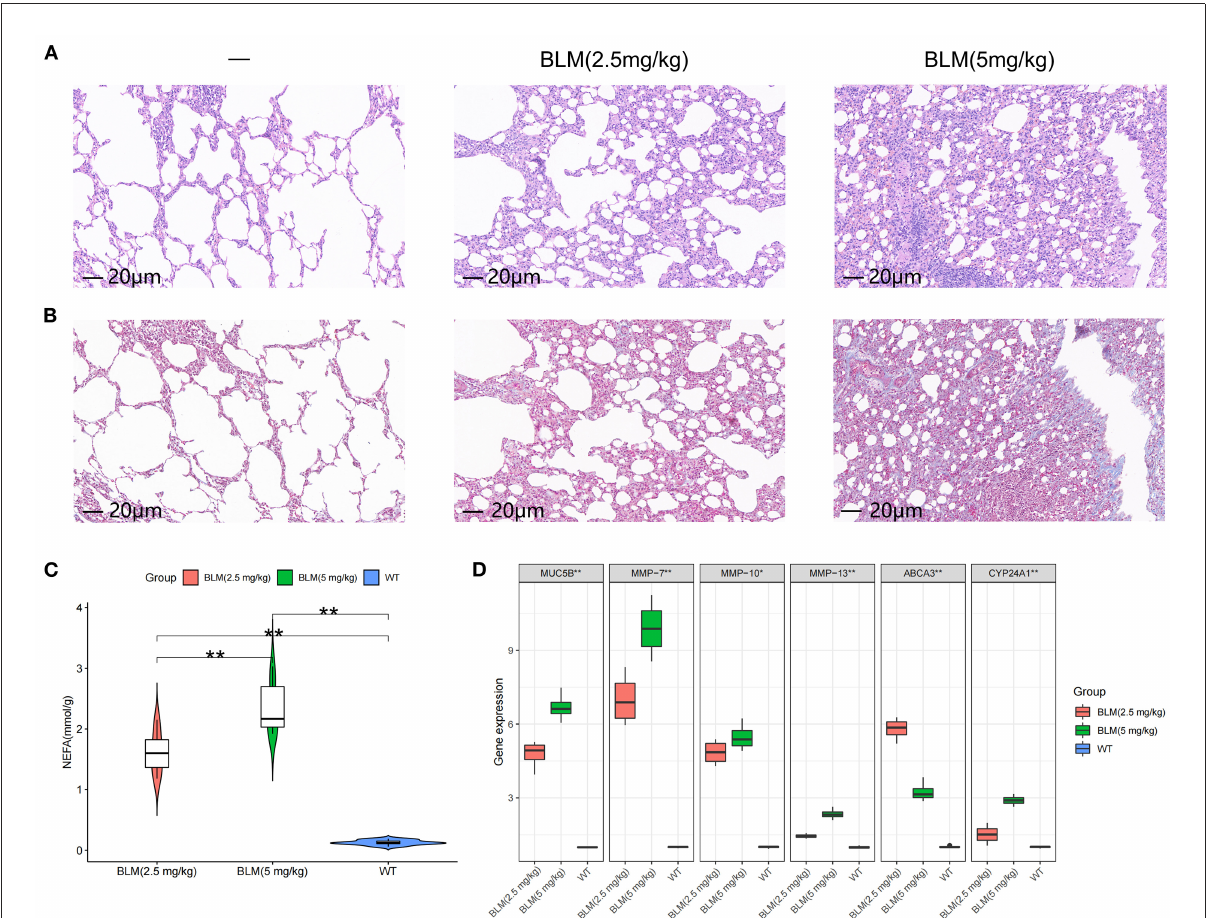
FIGURE4 Expression levels of fibrosis markers and fatty acid metabolism in rats with different degrees of pulmonary fibrosis. (A) Photomicrographs of lung sections stained with H&E. (B) Photomicrographs of lung sections stained with Masson Trichrome staining. (C) Content of free fatty acids in lung tissues of rats in each group. (D) Gene expression levels of fibrosis markers and key diagnostic genes in lung tissues of rats in each group. * P < 0.05, ** P < 0.01, *** P <